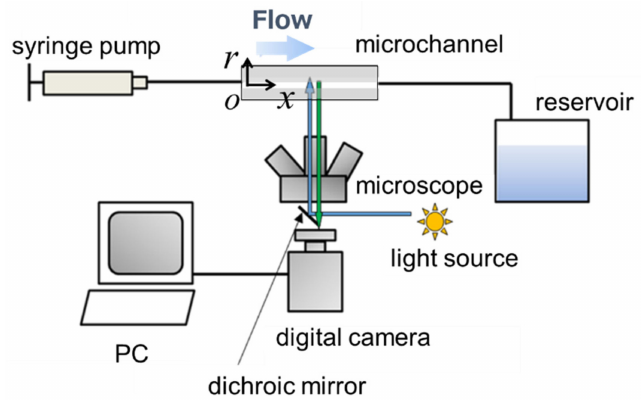
Figure 2. Schematic view of experimental apparatus. The measurement area was set parallel to the flow direction passing through the tube axis to measure both particle distribution in the radial direction and flow velocity.